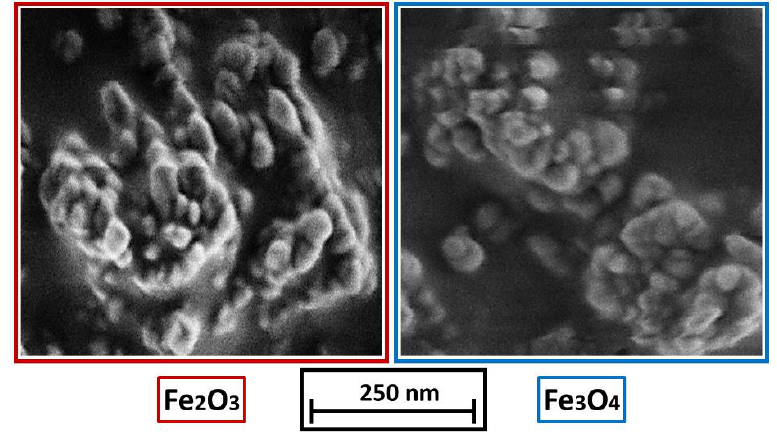
Figure 2. ( left ) : γ -Fe 2 O 3 nanoparticles, ( right ): Fe 3 O 4 nanoparticles. Figure 2. ( left ): γ -Fe 2 O 3 nanoparticles, ( right ): Fe 3 O 4